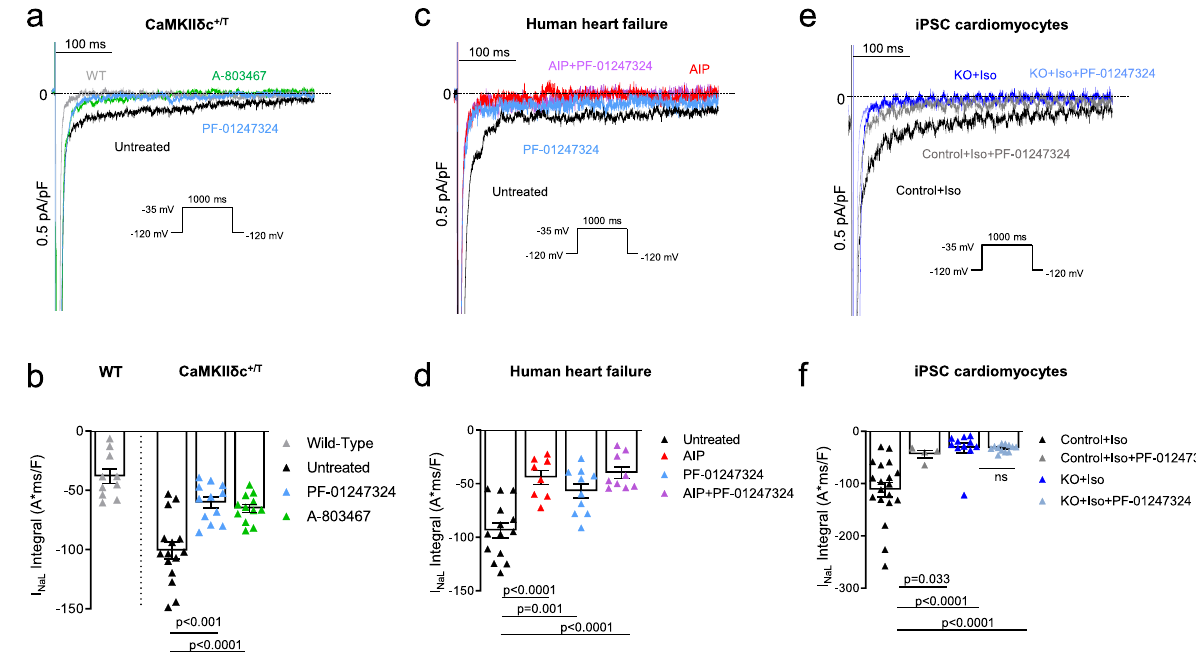
Fig. 2 Reduced I NaL upon Na V 1.8 inhibition in human failing and mouse CaMKII δ c transgenic cardiomyocytes, and in SCN10A knockout iPSC- cardiomyocytes. a Original traces of I NaL in WT and CaMKII δ c + /T mouse ventricular cardiomyocytes elicited using the protocol shown in the inset. b Mean data ± SEM along with individual values shown in the graph plotting WT ( n = 10 cells/5 mice) and CaMKII δ c + /T (untreated: n = 15 cells/7 mice; A- 806467: n = 12 cells/7 mice; PF-01247324: n = 12 cells/7 mice). Probability vs. untreated (One-way ANOVA with post hoc Bonferroni ’ s correction). c Original traces of I NaL from human failing ventricular cardiomyocytes elicited using the protocol shown in the inset. d Mean data ± SEM along with individual values shown in the graph plotting (untreated: n = 14 cells/8 patients; AIP: n = 8 cells/5 patients; PF-01247324: n = 10 cells/6 patients; AIP + PF-01247324 = 9 cells/5 patients). Probability vs. untreated (One-way ANOVA with post hoc Bonferroni ’ s correction). e Original traces of I NaL from human ventricular SCN10A knockout iPSC-cardiomyocytes elicited using the protocol shown in the inset. f Mean data ± SEM along with individual values shown in the graph plotting (control + Iso: n = 19 cells/3 cardiac differentiations; control + Iso + PF: n = 4 cells/3 differentiations; SCN10A knockout (KO) + Iso: n = 11 cells/3 differentiations; KO + Iso + PF-01247324 = 12 cells/3 differentiations). Probability vs. control + Iso (One-way ANOVA with post hoc Bonferroni ’ s